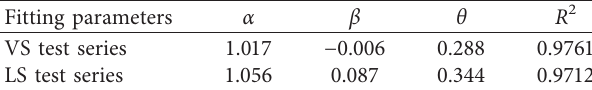
varied from 1.53 p